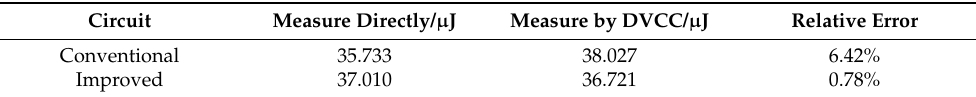
Table 5. Comparison of conduction loss measurement.